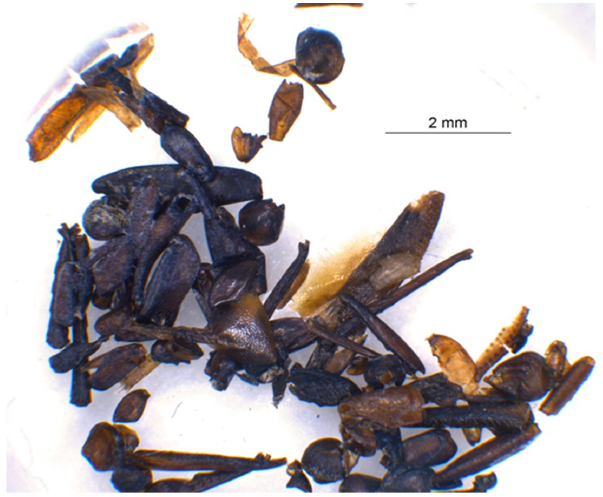
Figure 2. Examples of insect remains from well 990 that evidence the excellent conditions of preser- vation of organic material in the waterlogged layers. Photograph: Marguerita